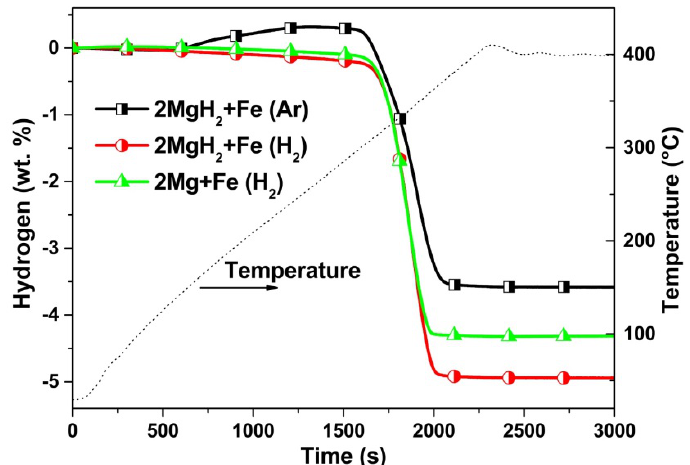
Figure 3. Curves of hydrogen desorption under 100 kPa of H 10 °C min − 1